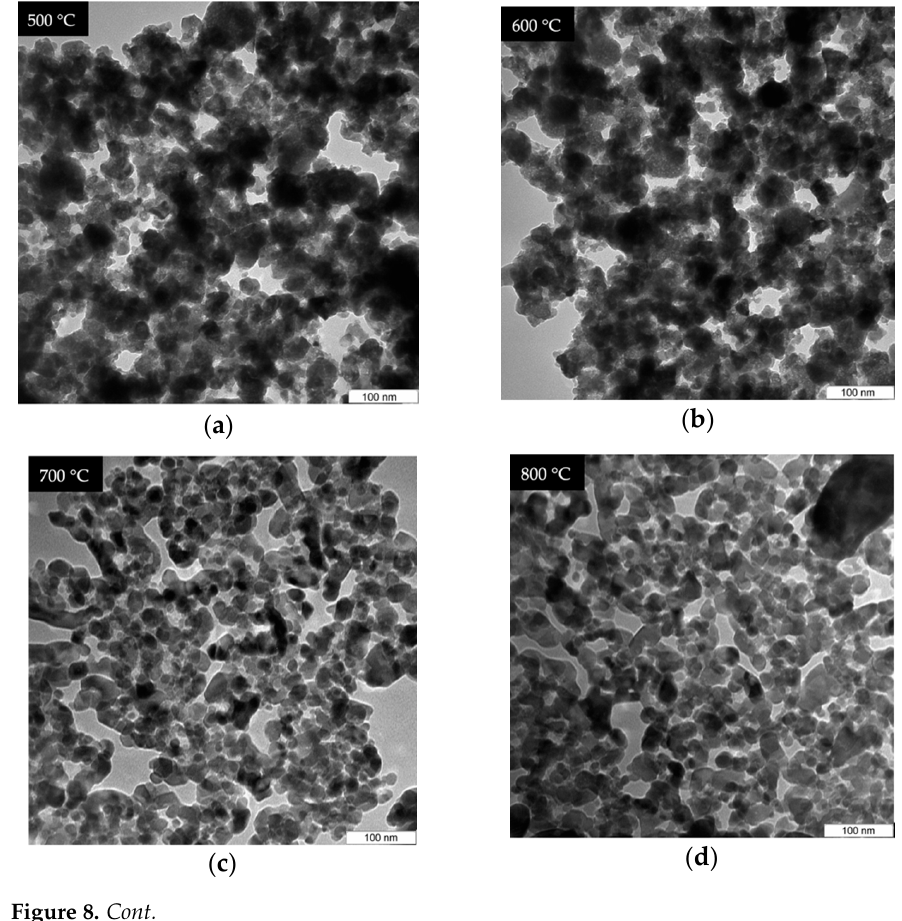
( f ) Figure 8. TEM analysis of willemite NPs calcined at different temperatures: ( a ) 500, ( b ) 600, ( c ) 700, ( d ) 800, ( e ) 900, and ( f ) 1000 °C. ( a )